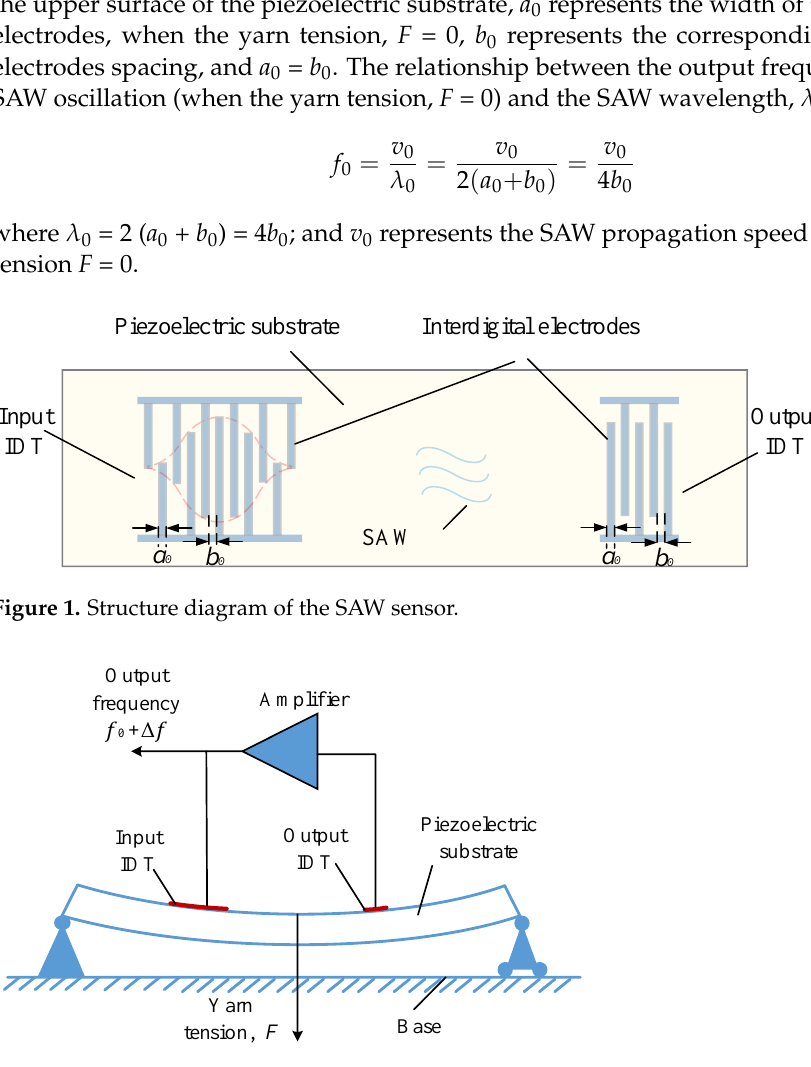
M Neutral plane of the beam F Figure 3. Schematic diagram of elastic deformation of the beam. From Figure 4a, a micro-segment of length dx is cut from the beam, shown in Figure 3, using two adjacent cross-sections. The deformation diagram of the micro-segment beam is shown in Figure 4b. Suppose that after the beam is bent (under the action of bending moment M ), the two cross-sections remain in plane but are turned around their respective neutral planes by an angle dθ . In the coordinate system of Figure 4, the x -axis is along the axis of the beam and the y -axis is along the height of the cross-section. In Figure 4b, the length variation, Δ dx , of the upper surface (height from the neutral plane is equal to h ) of the micro-segment is as follows: Δ dx = -hdθ